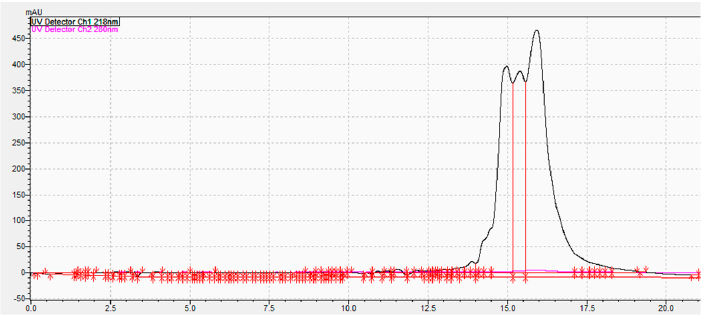
Figure 9. Reverse phase high-performance liquid chromatography (RP-HPLC) spectrum of piscine gelatine. Figure 10. Reverse phase high-performance liquid chromatography (RP-HPLC) spectrum of porcine gelatine.